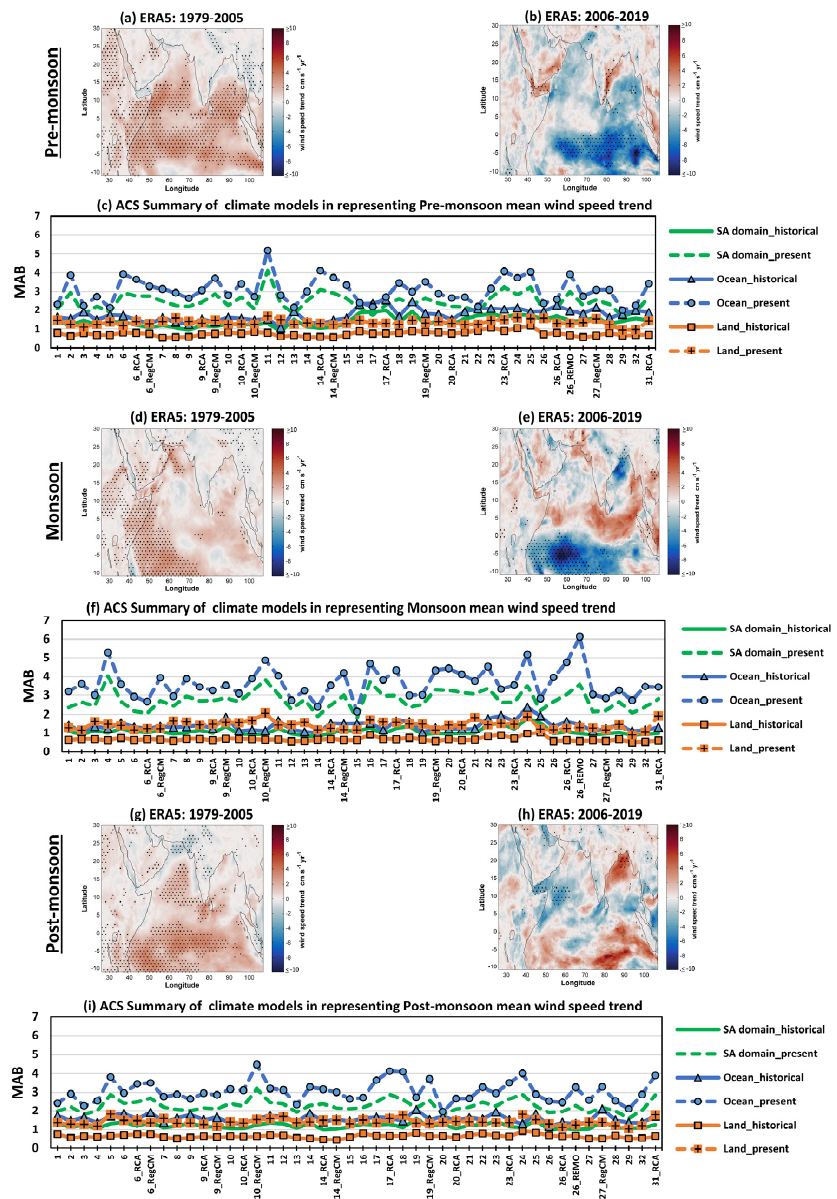
Figure 6. The ERA5 pre-monsoon mean wind speed trend maps with stippling for ( a )